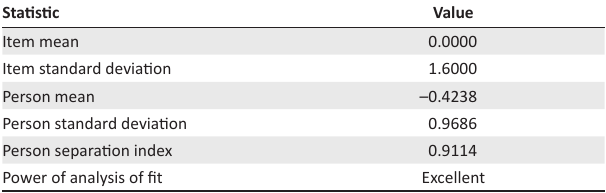
TABLE 1: Summary statistics of fractions, decimals and